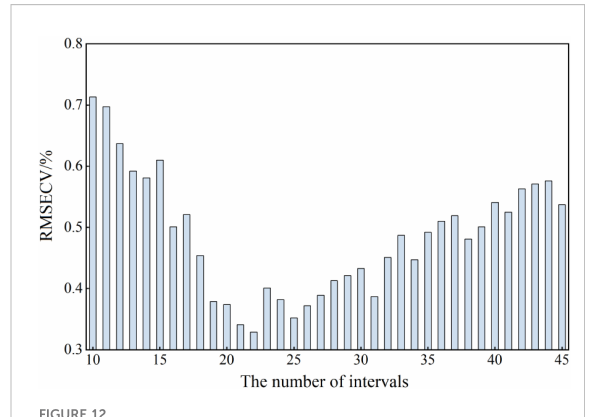
FIGURE 12 The results of the optimal number of isometric interval partitions.